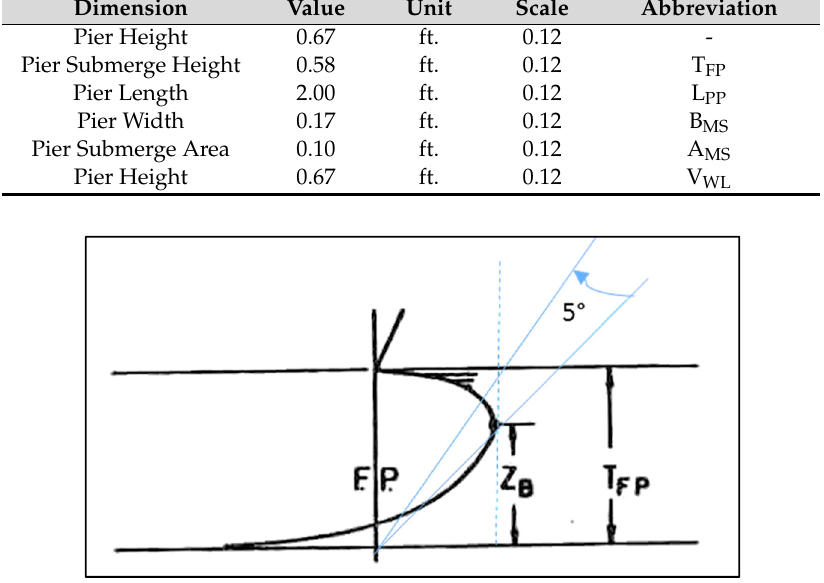
Figure 9. Pier wave ratio for 0° pitch angle bulb, L bb = 0.667 ′ and 1.833 ′ . Table 8. Pier model dimensions.